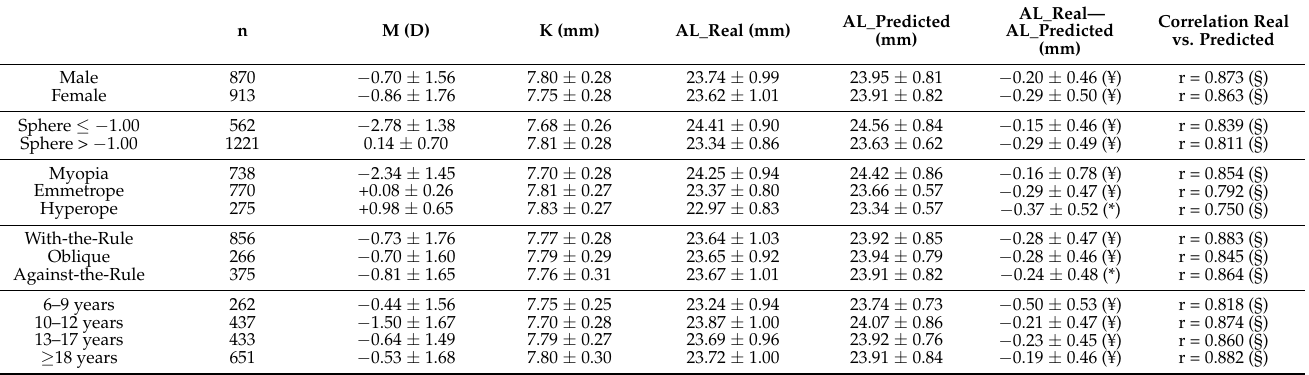
Table 1. Objective spherical equivalent refraction (M), mean keratometry (Kx), ocular axial length (AL_Real) and predicted ocular axial length (AL_Predicted) presented in mean ± SD, according to gender, sphere of refractive error, ametropia, type of astigmatism and age